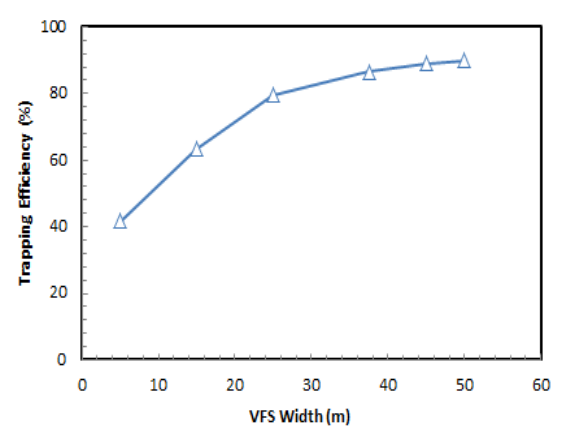
Fig. 6. Relationship between VFS widths and trapping efficiency of